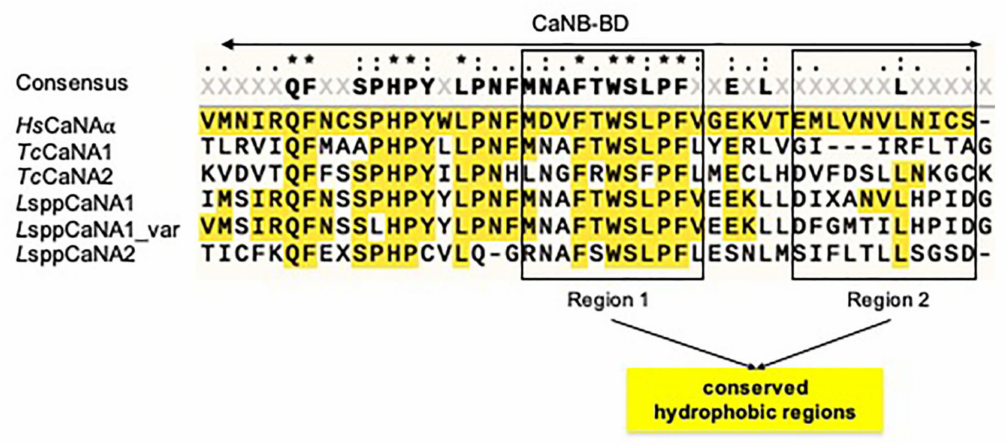
Figure 3. CaNB-BD sequence alignment present in CaNA. The boxes on the left and on the right correspond to the two hydrophobic regions present in CaNB-BD.